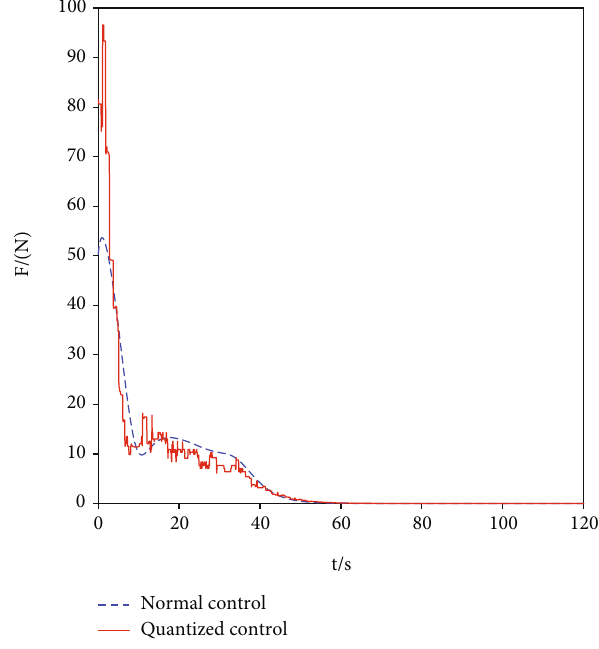
Figure 22: Control force curves.